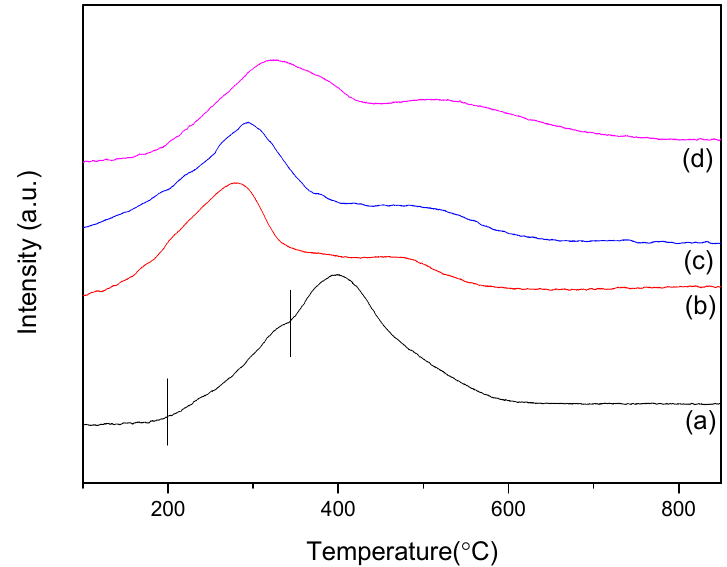
Figure 9. Temperature-programmed reduction (TPR) curves of catalysts. ( a ) PtSn-C, ( b ) PtSn-B, ( c ) PtSn-B-HCl5, and ( d ) PtSn-B-HCl35.